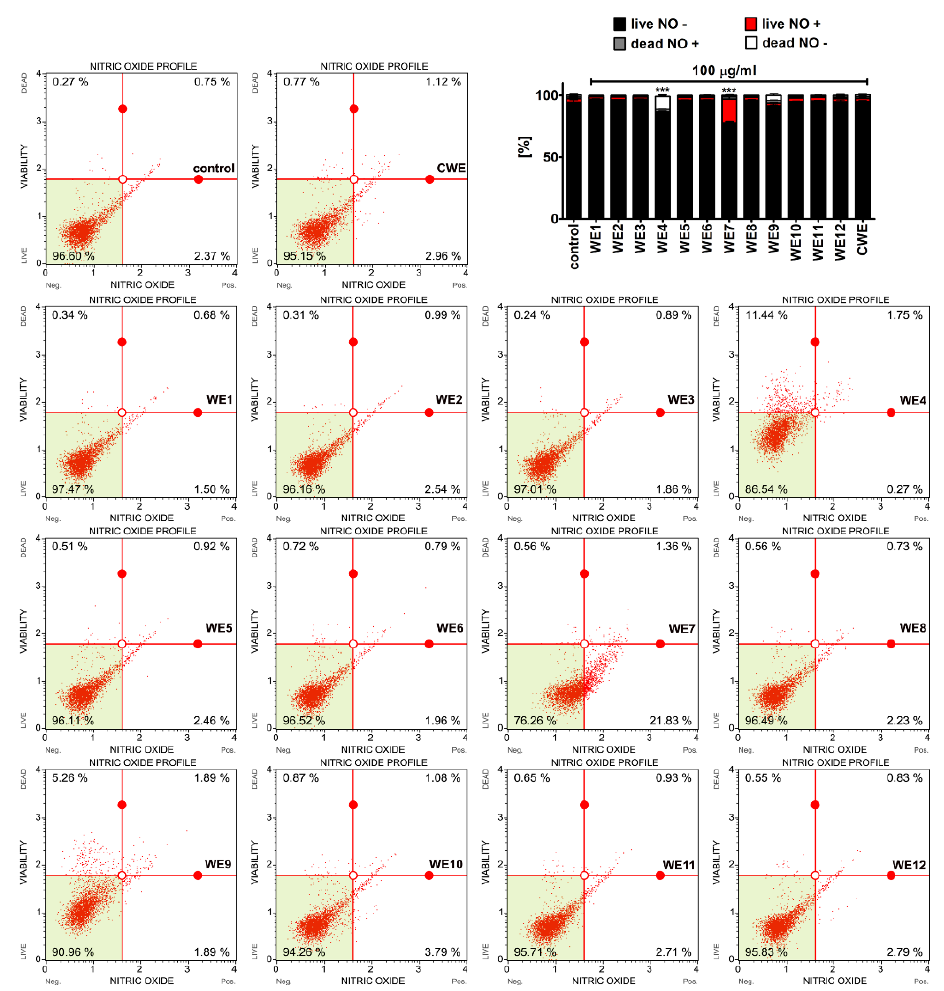
Figure 8. Extract-mediated changes in the levels of nitric oxide in BJ cells (100 μg/ml water extracts). The effects of water extracts (WE, twelve modified clones from WE1 to WE12) are shown. Control clone water extract is denoted as CWE. Nitric oxide levels were measured using a Muse ® Cell Analyzer and a Muse ® Nitric Oxide Kit. Representative dot-plots are presented. Bars indicate SD, n = 3. *** p < 0.001 compared to the control (ANOVA and Dunnett’s a posteriori test).